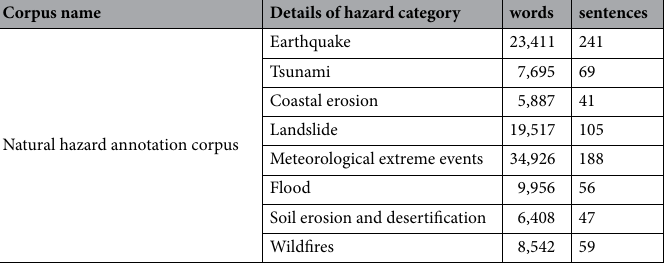
Table 1. Details of corpus sources.